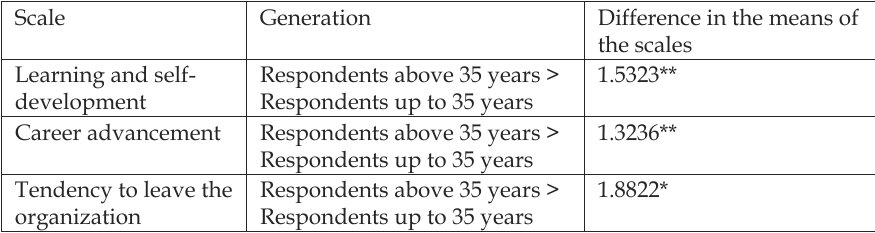
Tab. 6. Differences in scale means between the two generations that are found statistically signi (cid:222) cant.